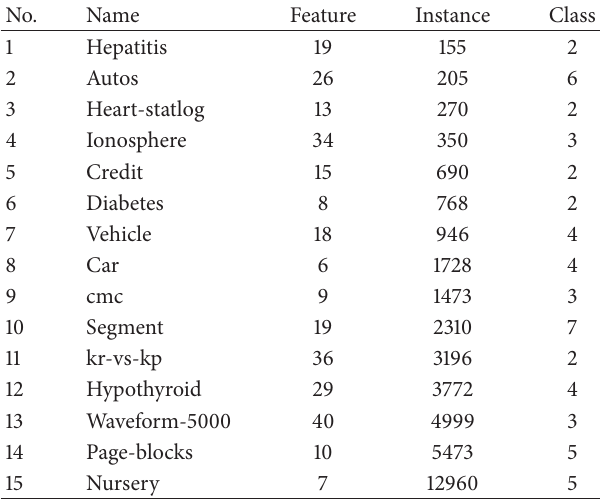
Table 2: Experimental datasets from the UCI